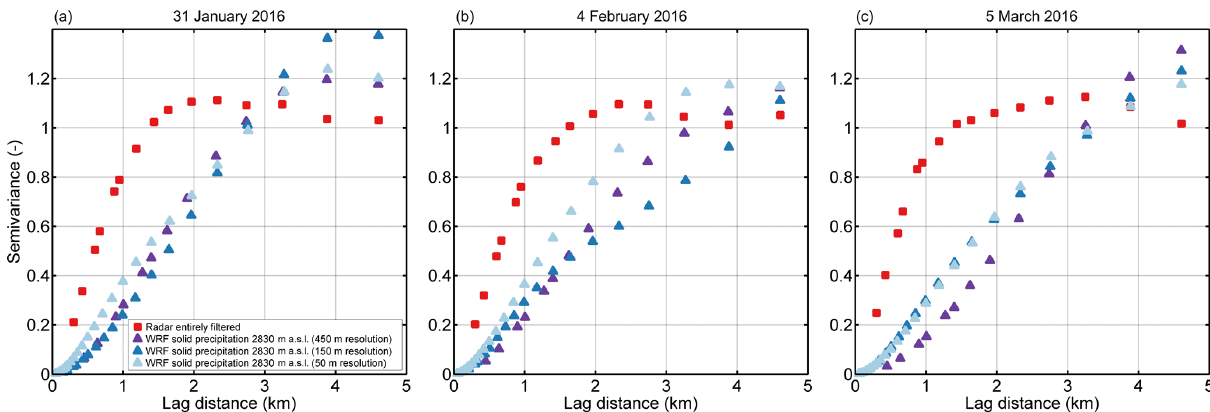
Figure 9. Variograms of detrended snow precipitation normalized by the domain-wide variance of precipitation for the precipitation events on (a) 31 January 2016, (b) 4 February 2016 and (c) 5 March 2016 for domain Dischma (Fig. 1). Variograms are given for entirely filtered radar snow precipitation (red) and WRF snow precipitation at 2830m above sea level (ma.s.l.) with 450m (violet), 150m (blue) and 50m (light blue) resolution. WRF snow precipitation is from simulations with weak terrain smoothing (Sect. 2.1). Radar precipitation is